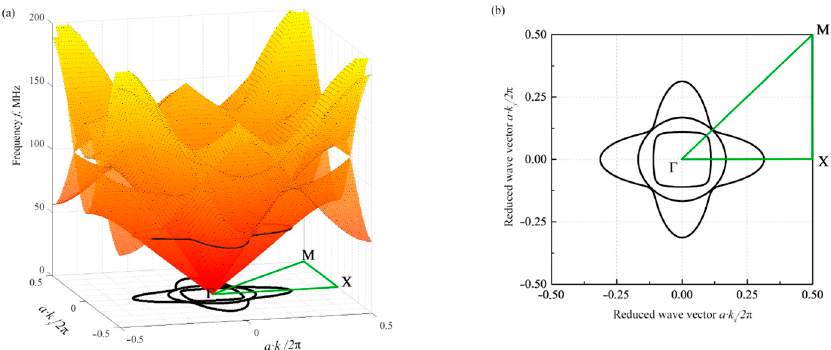
Figure 4. Band structure of a two-dimensional phononic crystal with a normalized hole diameter d/a = 0.8: ( a ) the first three dispersion surfaces corresponding to the three lowest acoustic modes in a phononic crystal and ( b ) projection of the dispersion surface contour lines onto the first Brillouin zone at an isofrequency f 0 = 50 MHz.